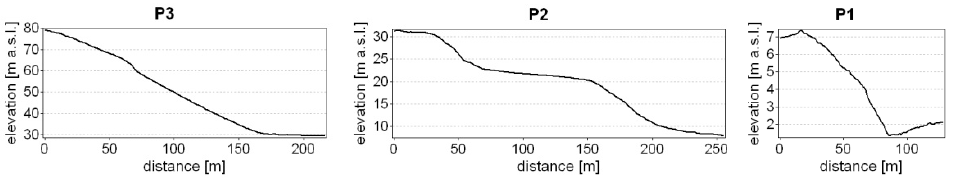
Figure 11. Elevation profiles along the terraces.